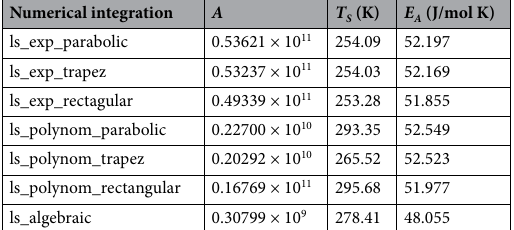
Table 2. Numerical values of kinetic parameters determined using various integration methods for β = 20, δ_random_T’ = 0.0, N polynom = 7.